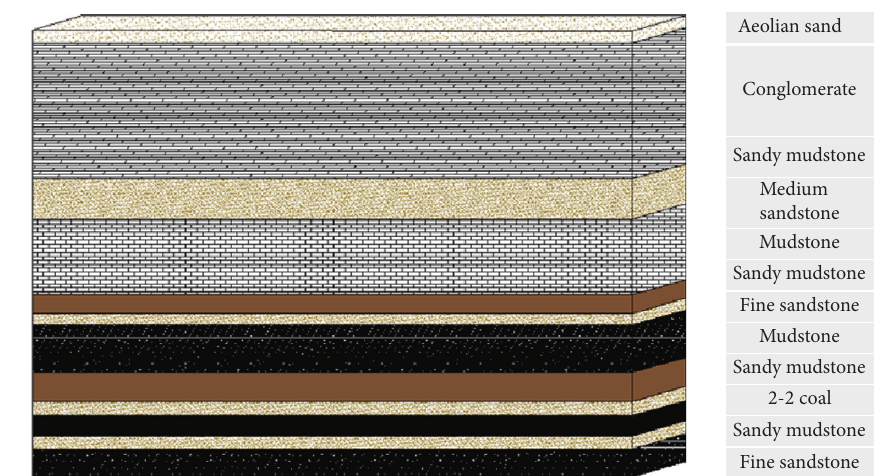
Figure 3: Schematic diagram of similar material